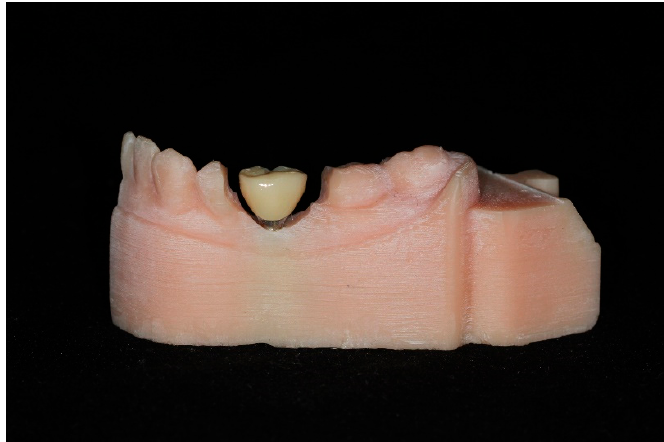
Figure 4. Screw-up abutment and crown on milled resin model.